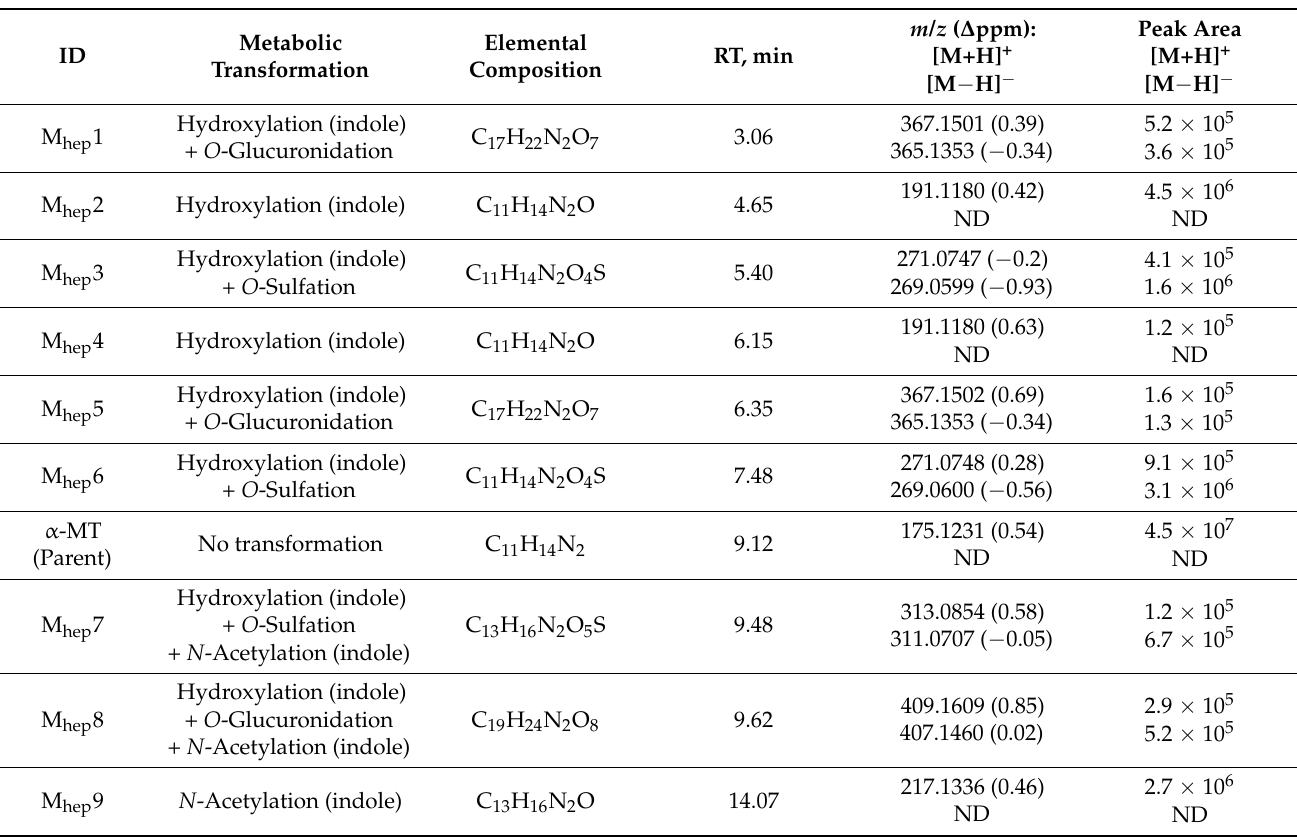
Table 1. Metabolic transformation, elemental composition, retention time (RT), accurate mass of molecular ion in positive- and negative-ionization modes ([M+H] + and [M − H] − , respectively) with mass error, and liquid chromatography–high-resolution mass spectrometry peak area of α -MT and metabolites after 3 h incubation with human